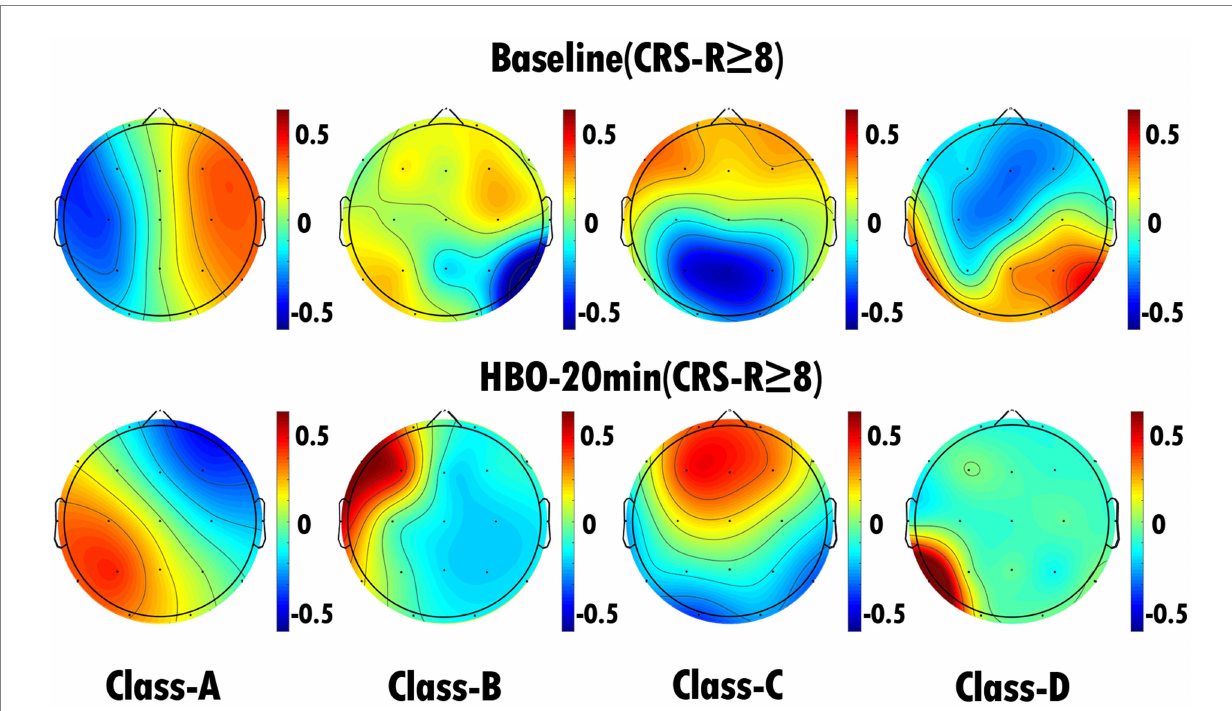
FIGURE 3 EEG microstate topography of DOC patients (17 cases) with CRS-R ≥ 8. The top row is the EEG microstate topography map of the patients before HBO therapy, and the bottom row is the EEG microstate topography map of the patients after 20 min of HBO therapy. We found that the duration of microstate C was significantly increased ( p < 0.05) and the contribution of microstate D was significantly decreased ( p < 0.05) after 20 min of HBO therapy compared with the pretreatment